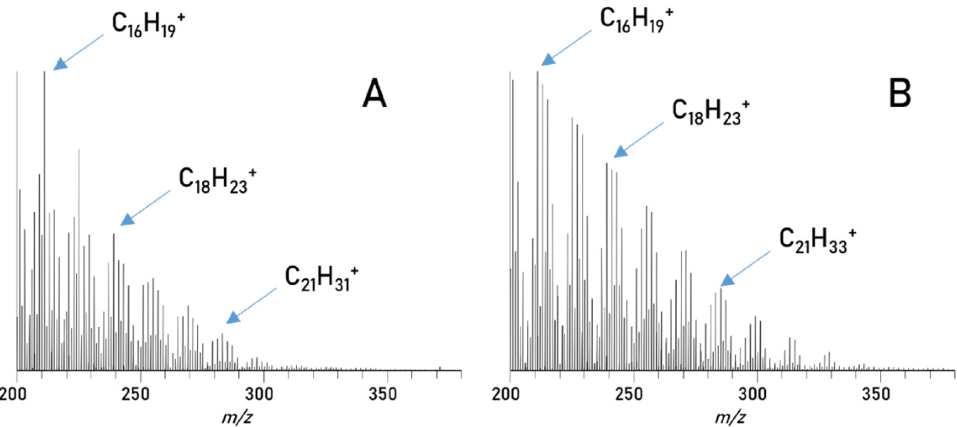
Figure 7. Spectra of diesel compounds: ( A ) direct injection of diesel 1, ( B ) diesel compounds in blend 1 from 0.8–1.6 min.